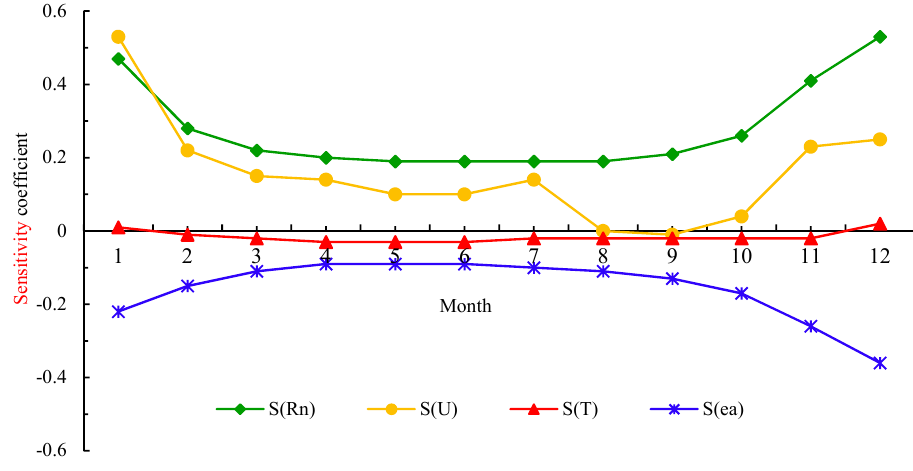
Figure 5. Variation of monthly mean sensitivity coefficient in Weihe River